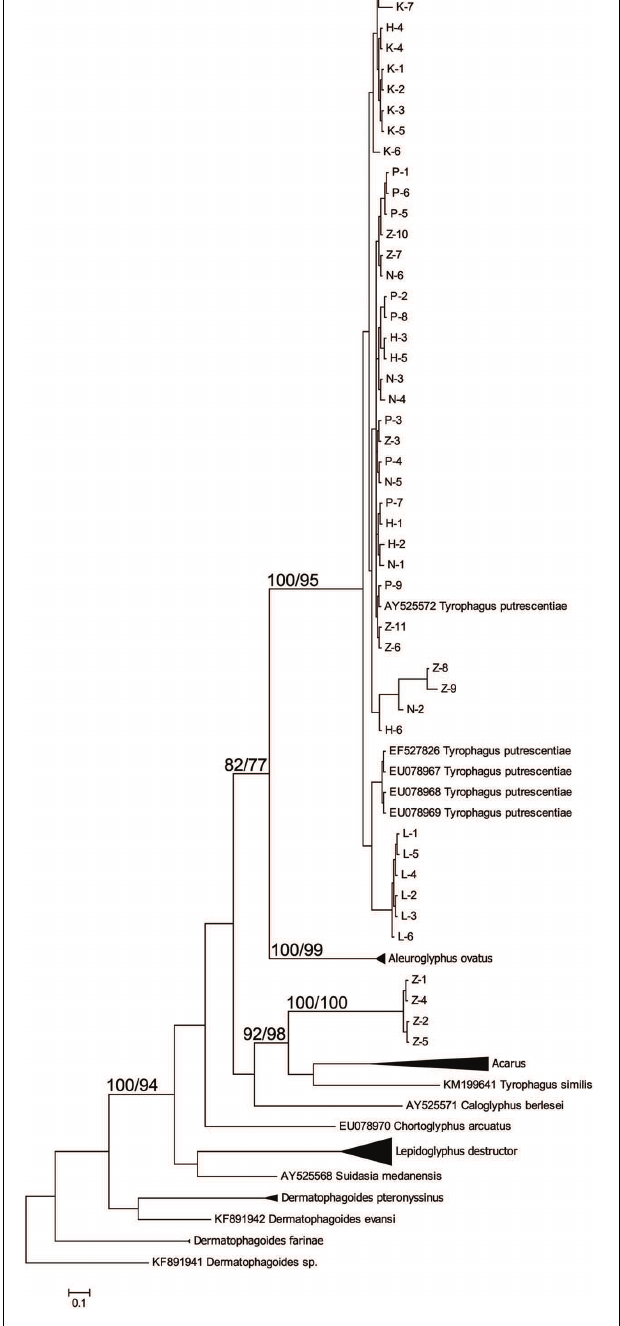
FIGURE 1 | Phylogenetic analysis of the CO1 clones of Tyrophagus putrescentiae with the reference sequences from other related astigmatid mites (Webster et al., 2004; Dermauw et al., 2009; Klimov and OConnor, 2009a,b; Bochkov et al., 2014; Ge et al., 2014; Sun et al., 2014). The phylogeny was inferred by Bayesian analysis of 46 partial CO1 gene sequences from observed populations, i.e., L, laboratory; K, Koppert; P, Phillips; D, Dog; H, Ham; and Z, field Zvoleneves. Branch lengths correspond to the mean posterior estimates of evolutionary distances (scale bar: 0.5). Branch labels indicate the Bayesian posterior probabilities and bootstrap support values from maximum likelihood